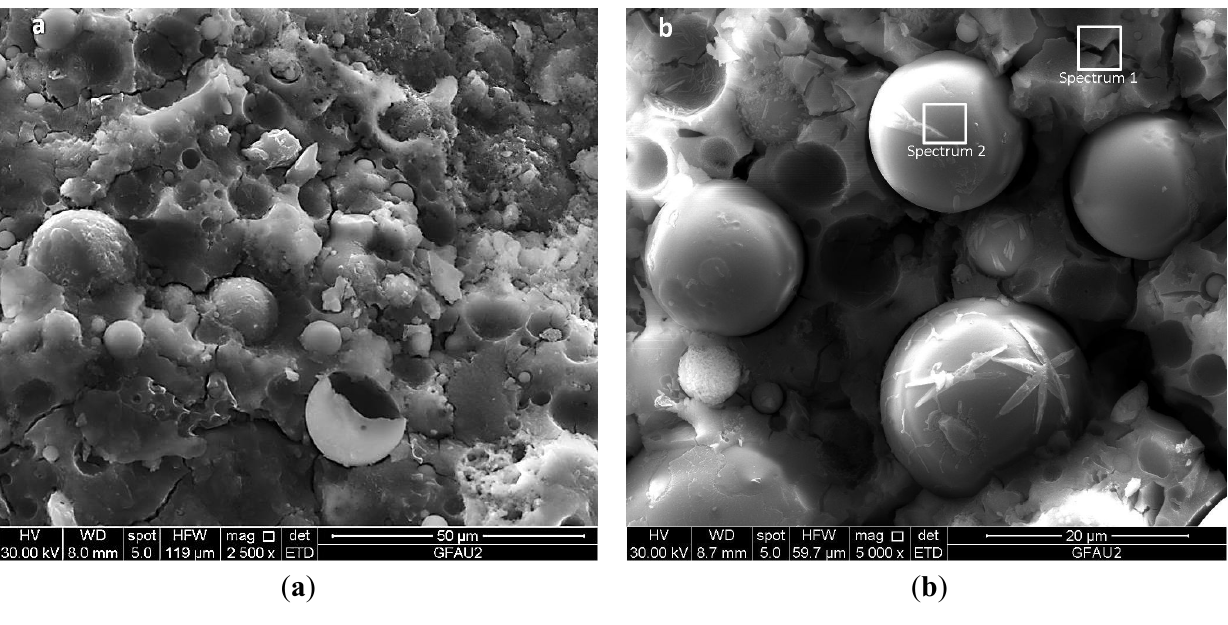
Figure 2. SEM micrographs of the geopolymer binder at ( a ) 2500× and ( b ) at